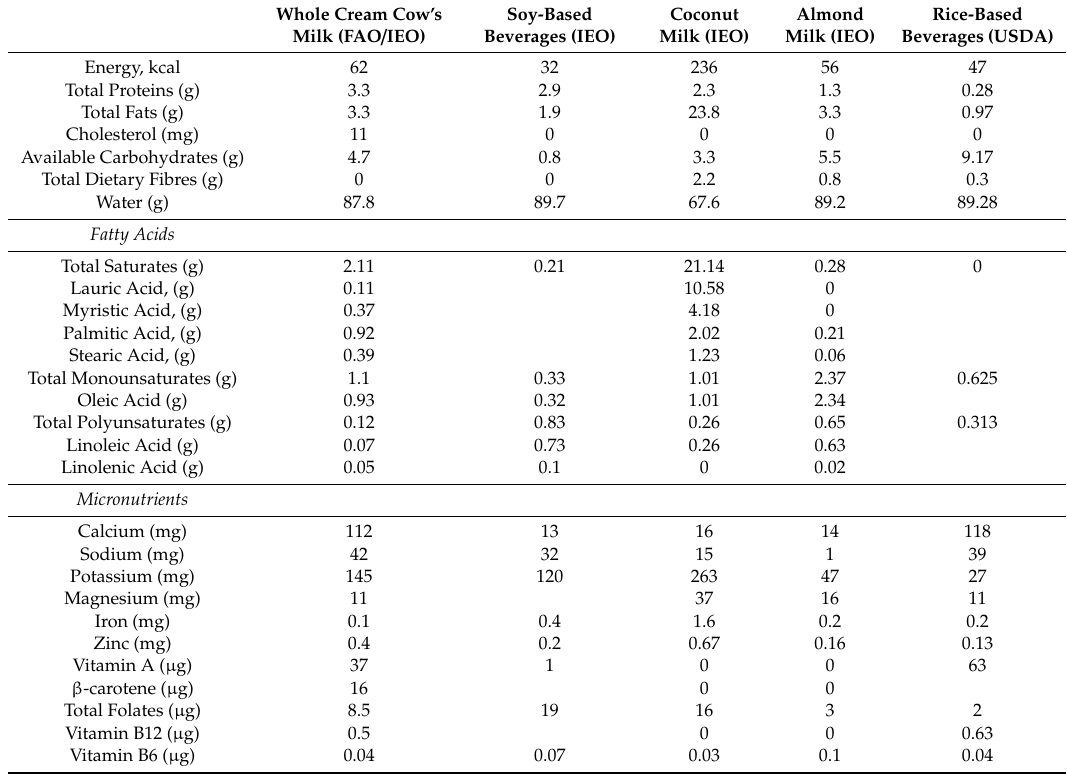
Table 3. Nutritional comparison (per 100 g) between cow’s milk vs. selected plant-based milk alternatives